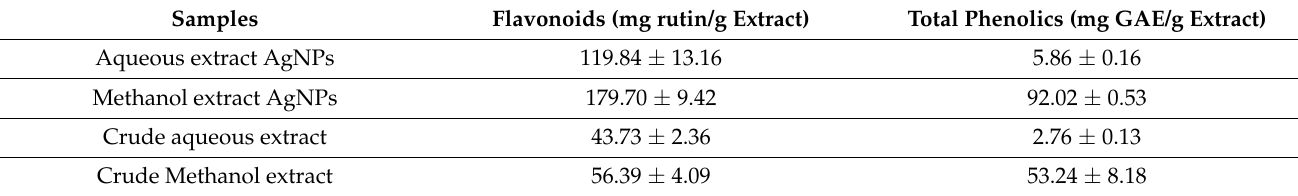
Table 1. Total phenolic and flavonoid contents of synthesized C. papaya leaf extracts silver nanoparticles.